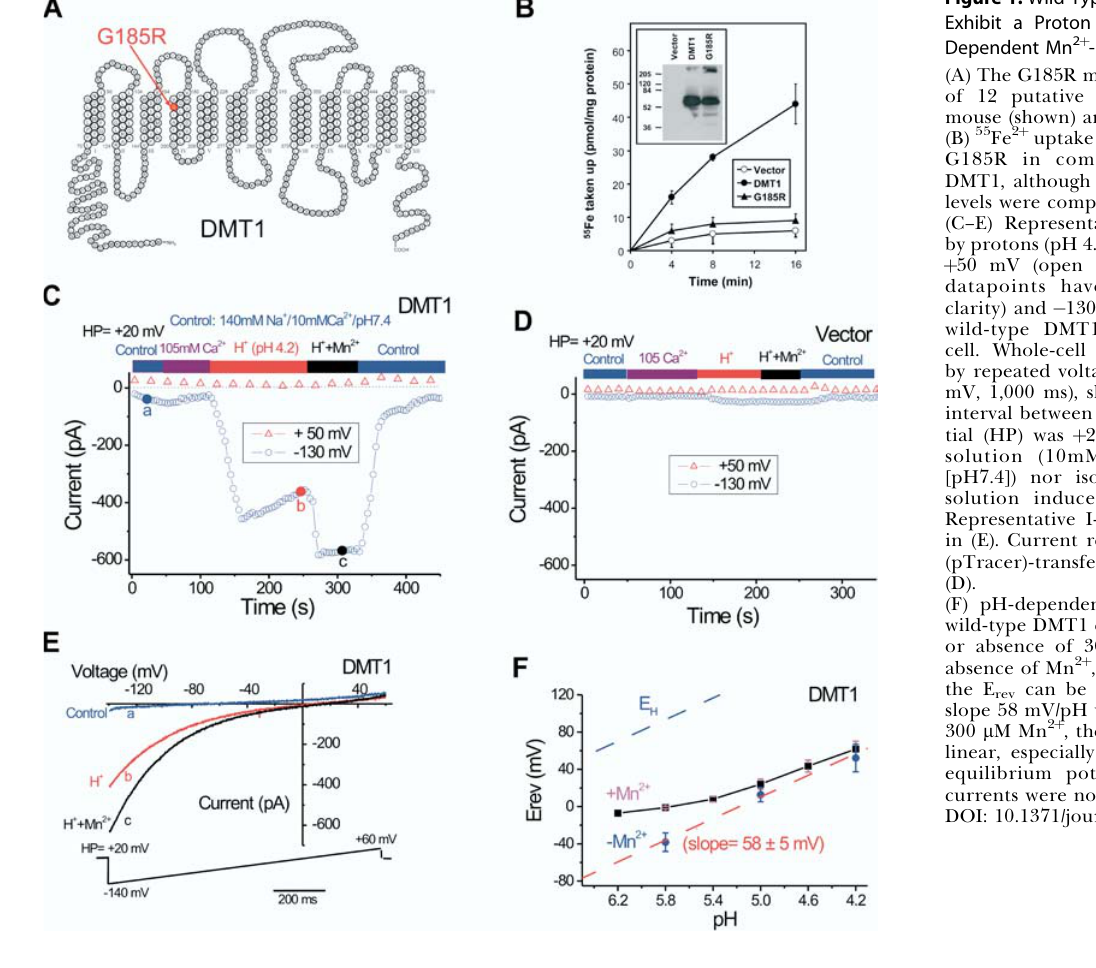
Figure 1. Wild-Type DMT1-Expressing Cells Exhibit a Proton Current and a Proton- Dependent Mn 2 þ -Induced